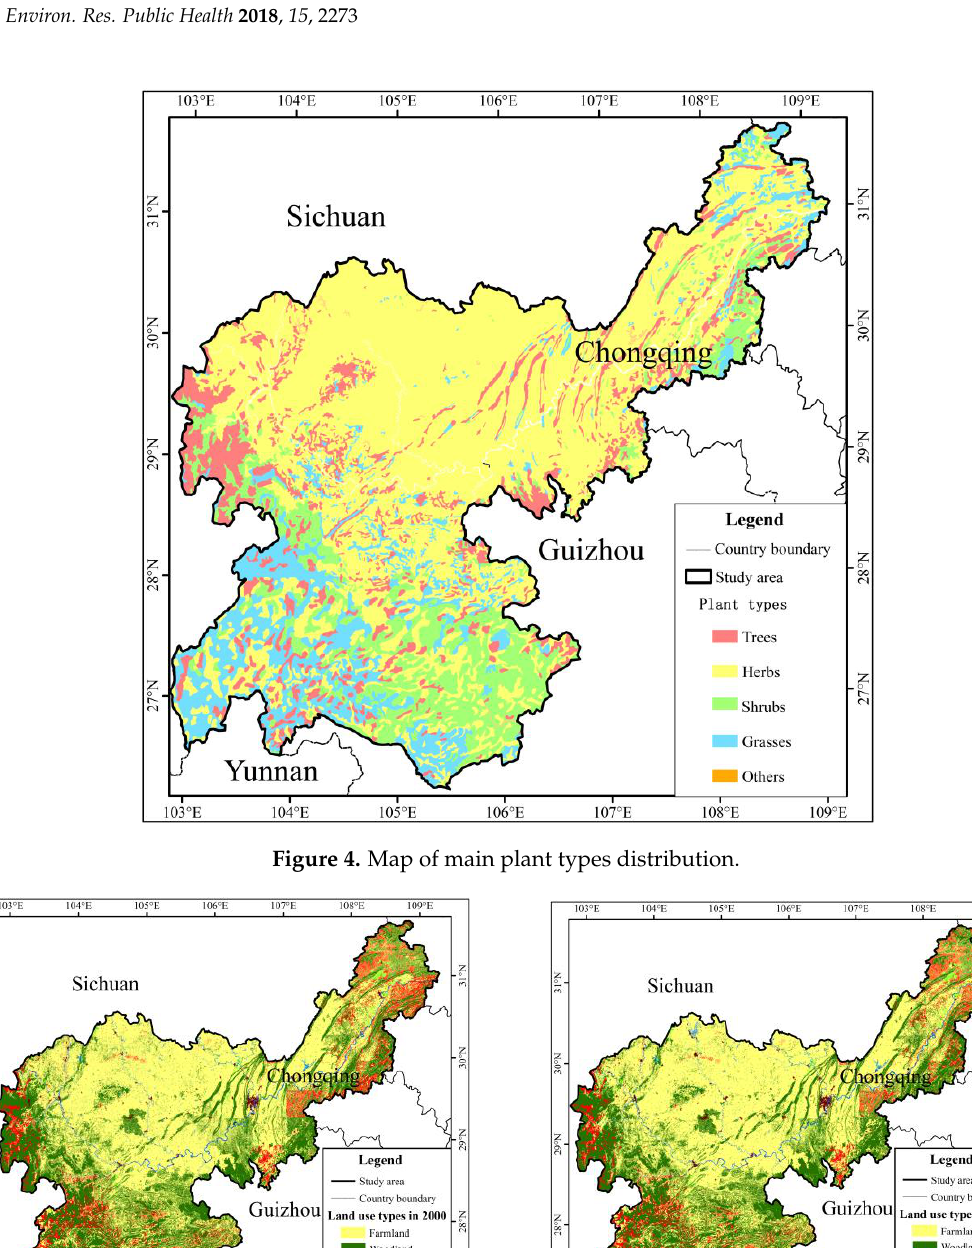
Figure 3. Map of soil types distribution.